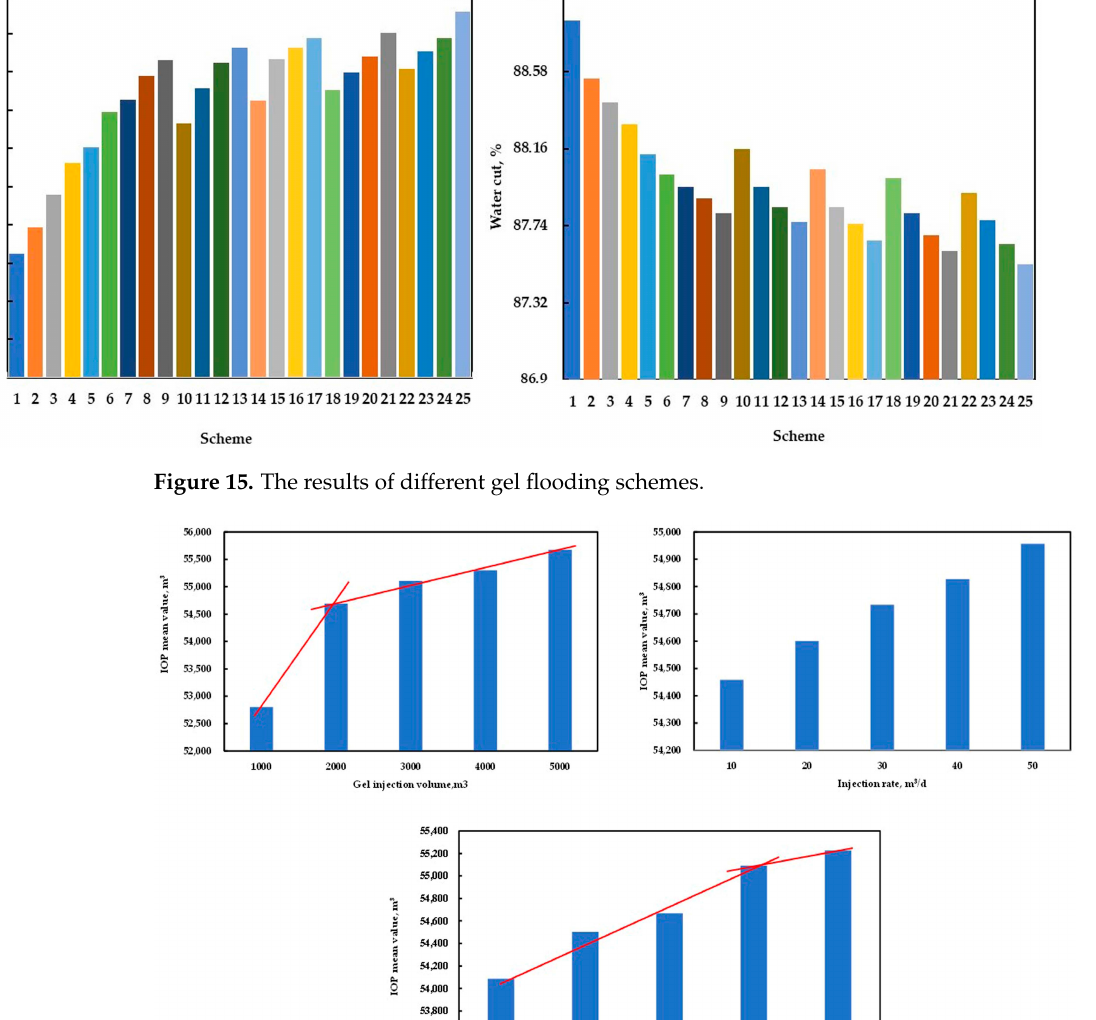
Figure 18. The remaining oil saturation distribution comparison between the optimal gel flooding scheme and water flooding. 4. Conclusions For a conglomerate reservoir, it is easy for a dominant water-flow channel to form during the high water cut period, but gel flooding is an effective method to solve this problem. However, the optimal design speed of gel flooding is affected by many factors,